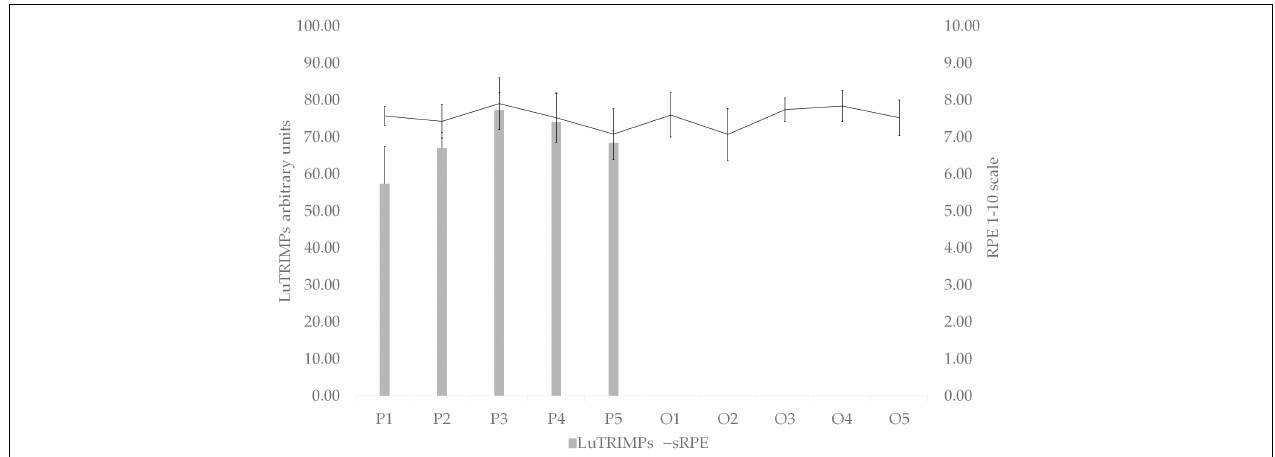
FIGURE 2 | Weekly (1–5) load in presential sessions (P) and online sessions (O) during quarantine periods expressed in RPE and LuTrimp. n = 21.